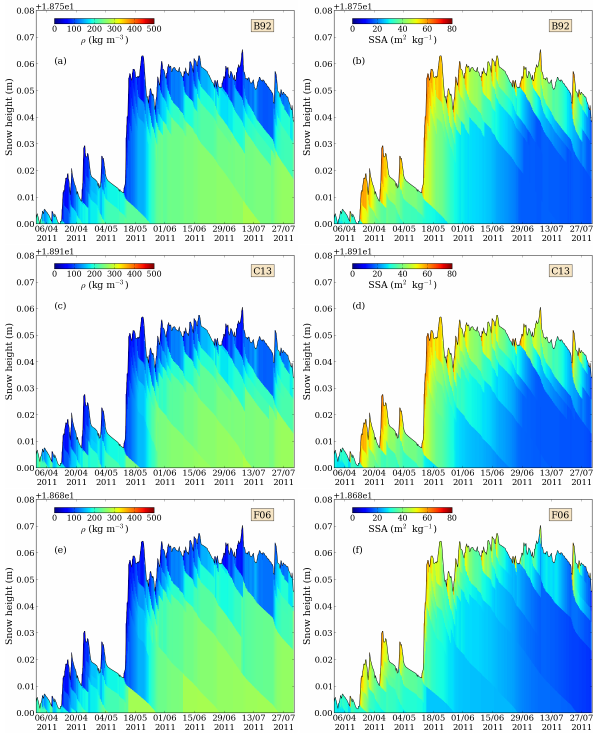
Fig. 6: Simulated density (left column) and SSA (right column) at Summit from 1 April to 31 July Fig. 6. Simulated density (left column) and SSA (right column) at 2011. Simulations were run using different metamorphism formulations. From top to bottom: B92 Summit from 1 April to 31 July 2011. Simulations were run us- (Brun et al., 1992), C13 (this work) and F06 (Flanner and Zender, 2006). ing different metamorphism formulations. From top to bottom: B92 (Brun et al., 1992), C13 (this work) and F06 (Flanner and Zender, 34